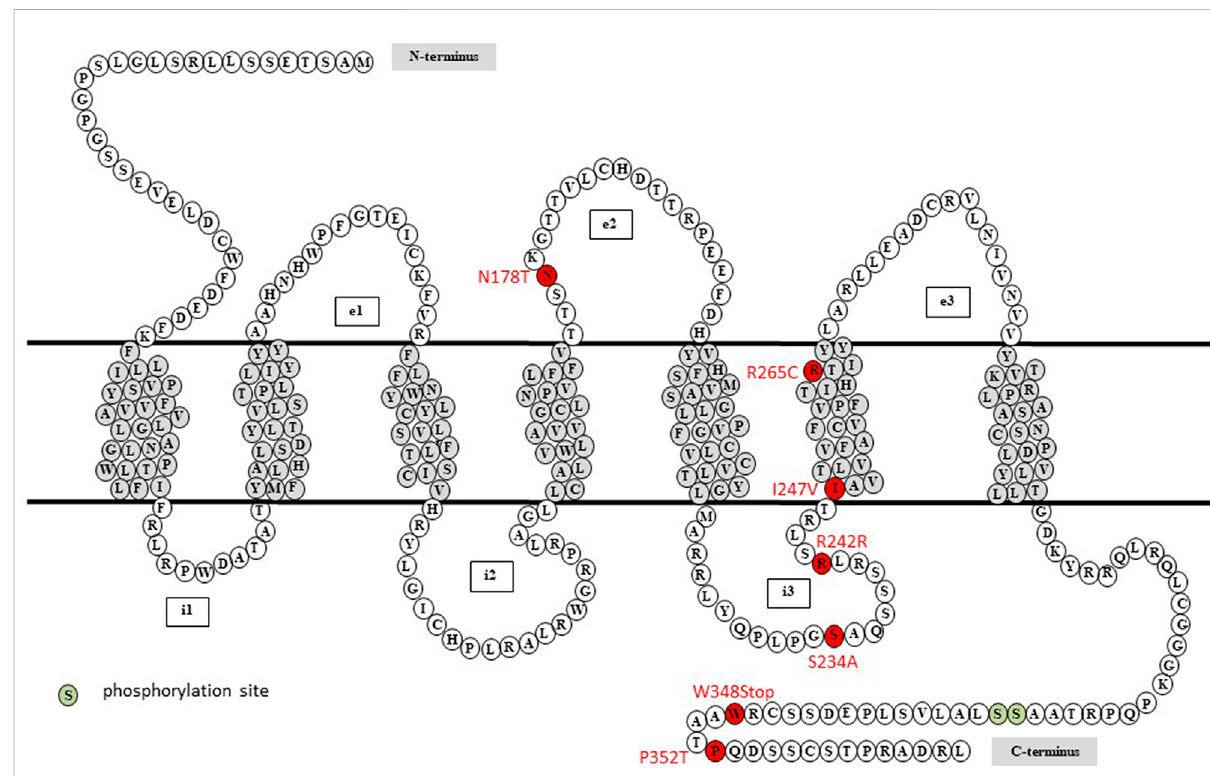
FIGURE 1 Localization of the seven mutations corresponding to identi fi ed polymorphismsin the human P2RY4 gene in individuals included in the GENES study. Among the identi fi ed variants (in red), the N178T polymorphism is located in the second extracellular loop (e2), S234A and R242R in the third intracellularloop(i3),I247VandR265Cinthesixthtransmembranedomain,andW348StopandP352TintheC-terminusofthehumanP2Y 4 receptor amino acid sequence. Potential phosphorylation sites are indicated in